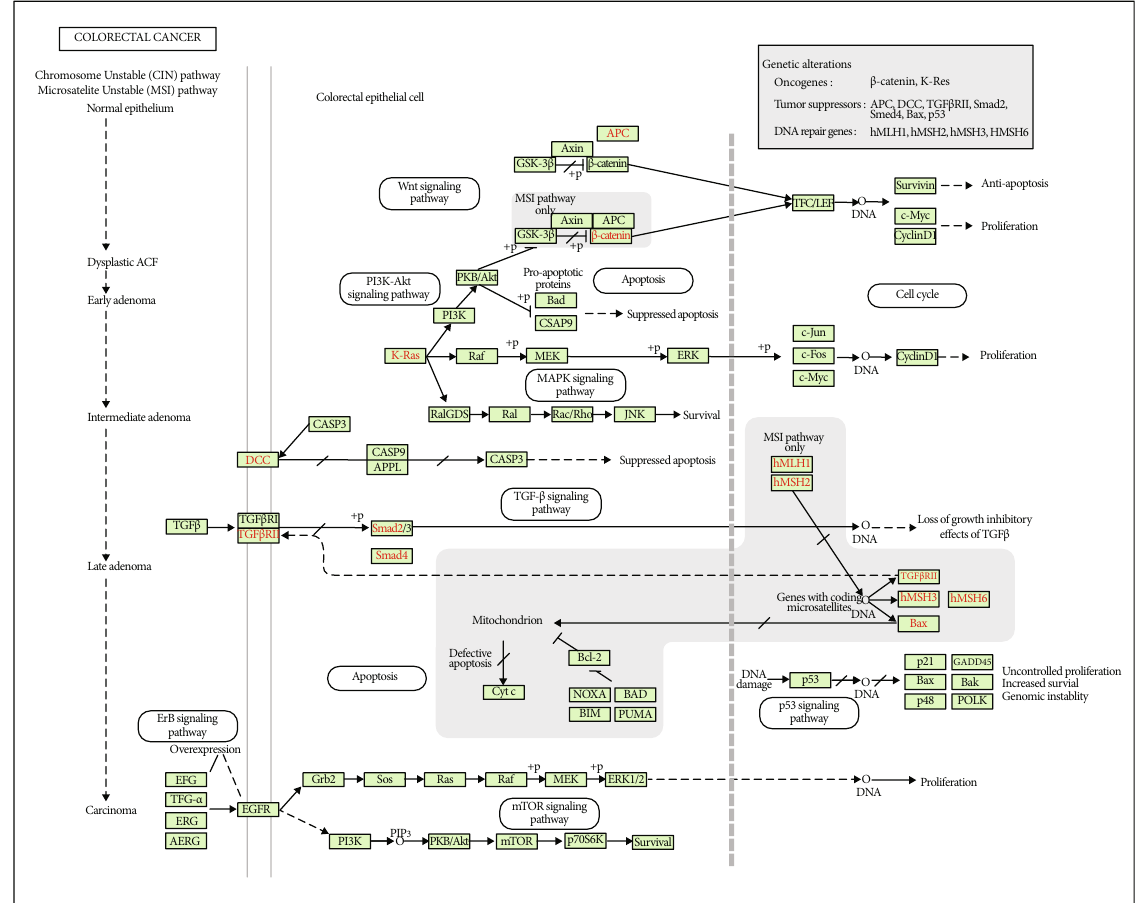
Figure 4: Enriched KEGG pathway for colorectal